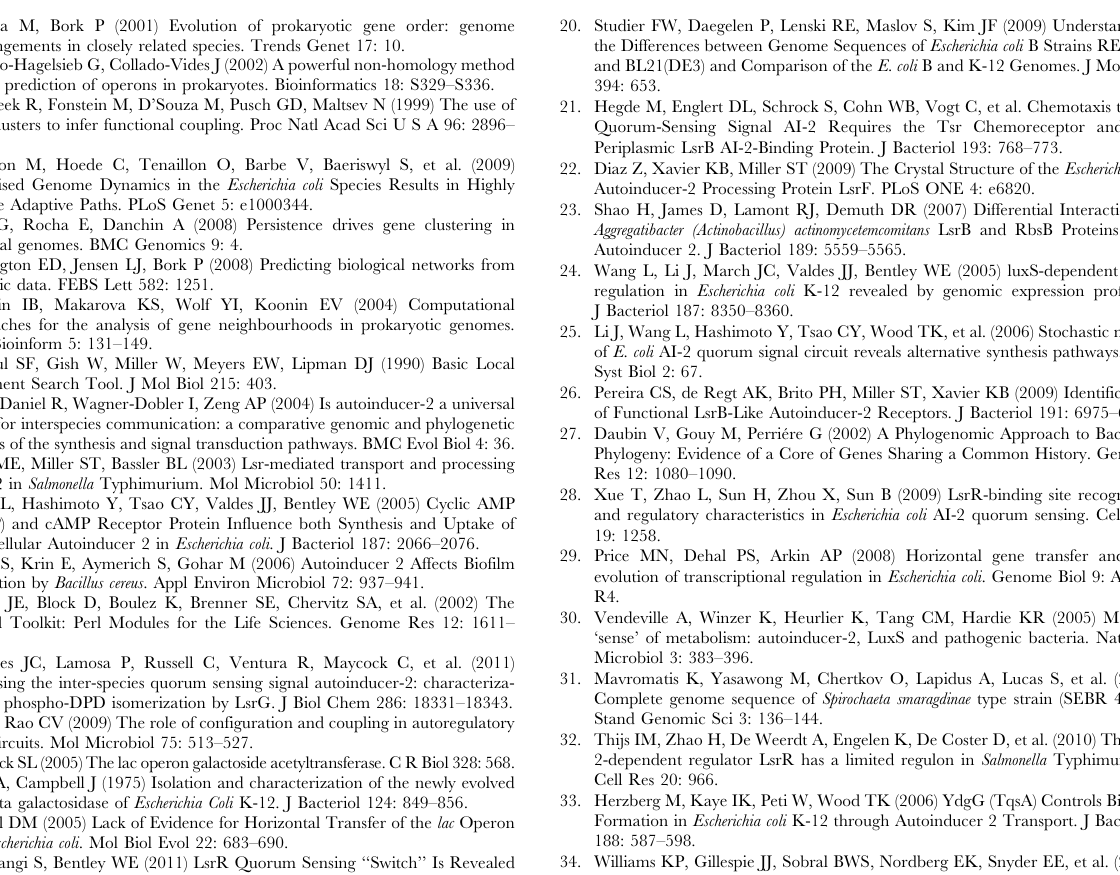
Table S1 Trackback plot subcategories for Figure S1. Species represented in the trackback plot from an E. coli K-12 W3110 Lsr system expanded window stringent